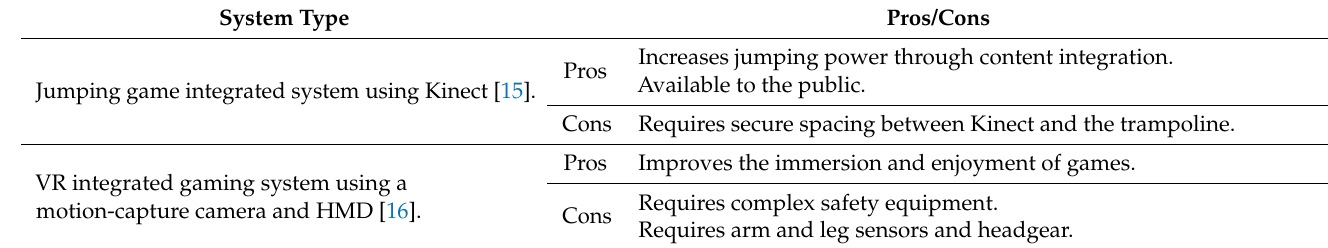
Table 1. Cont. System